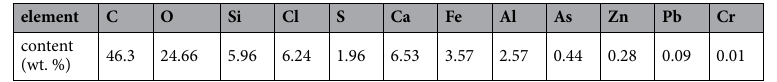
Table 1. Main Chemical Composition of Germanium-Rich Coal Fly